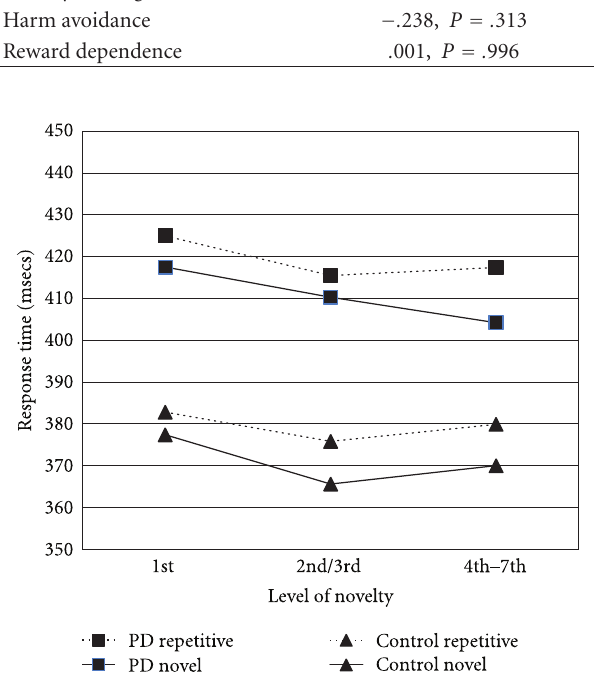
Figure 2: Comparison of the PD and control participants for response times when the target stimuli appeared in the repetitive or novel location and by how many times the novel stimuli had been presented (level of novelty).